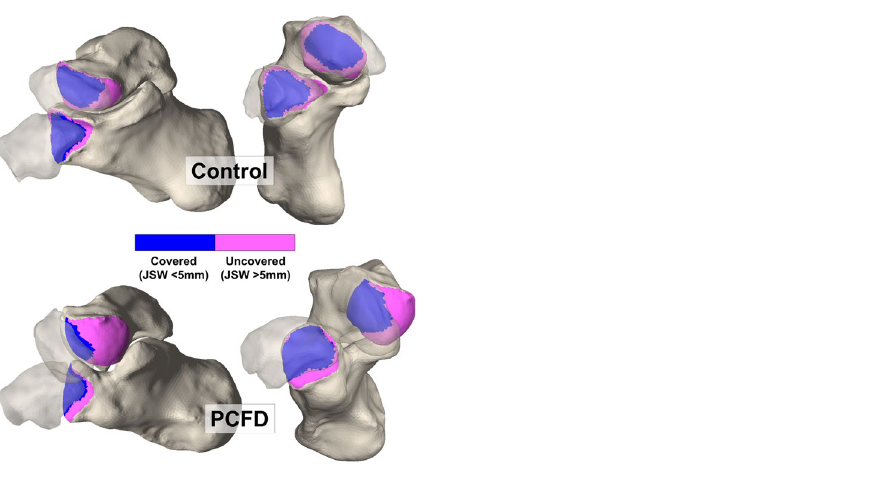
Figure 2. Medial and anterior views of the Chopart joint in representative coverage maps of control and Progressive Collapsing Foot Deformity feet. PCFD tended toward decreased medial coverage and increased lateral coverage in both the calcaneocuboid and talonavicular